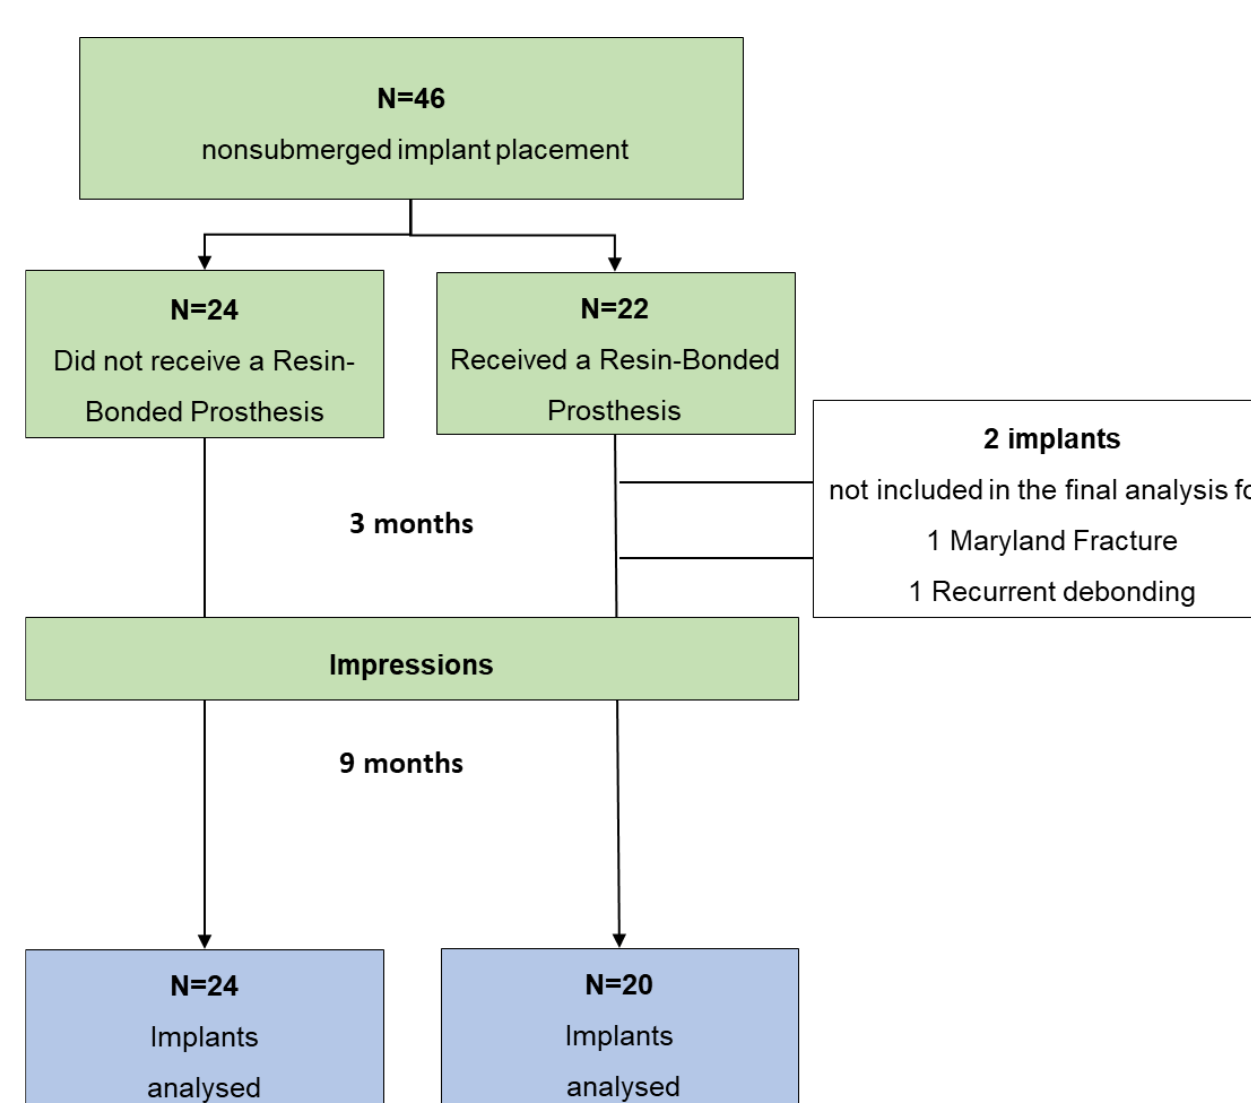
6 Figure 2. The following radiographic parameters were evaluated to measure MBL M (Mesial Mar- ginal Bone level), MBL D (Distal Marginal Bone Level), CEJ M (Mesial Cement–Enamel Junction), CEJ D (Distal Cement–Enamel Junction), Area M (Mesial Bone level Area) and Area D (Distal Bone